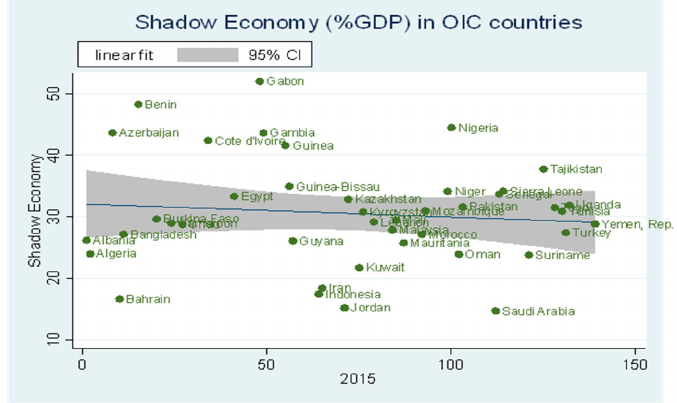
Figure 2. The average size of the shadow economy (% of GDP) in OIC. Source: authors’ estimations.